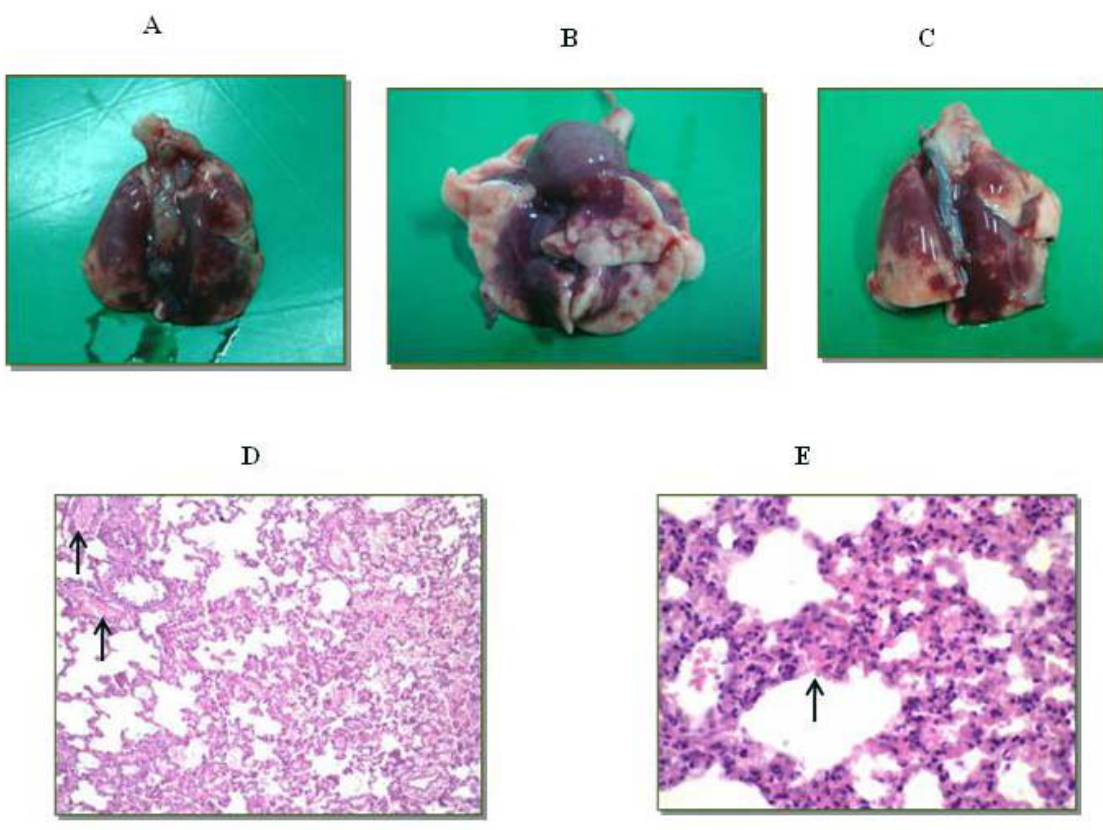
Figure 3. Lungs of the animals in groups B and C, which were subjected to experimental envenomation using Tityus serrulatus venom; ( A to C ) extensive hemorrhagic areas in the whole organs, and histological sections revealing ( D ) capillary congestion (arrowed) and ( E ) presence of erythrocytes in the parenchyma